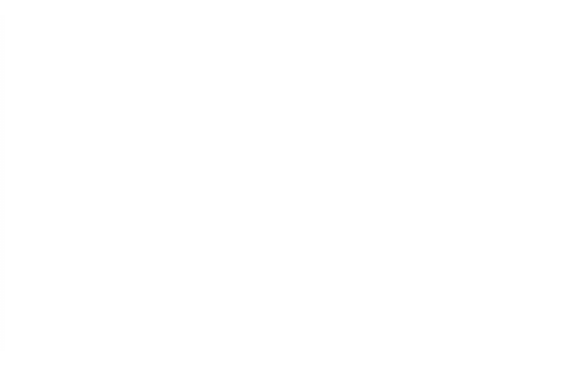
Figure 4. Schematic diagram of collision with the J constraint on the right vertex of the parking space.